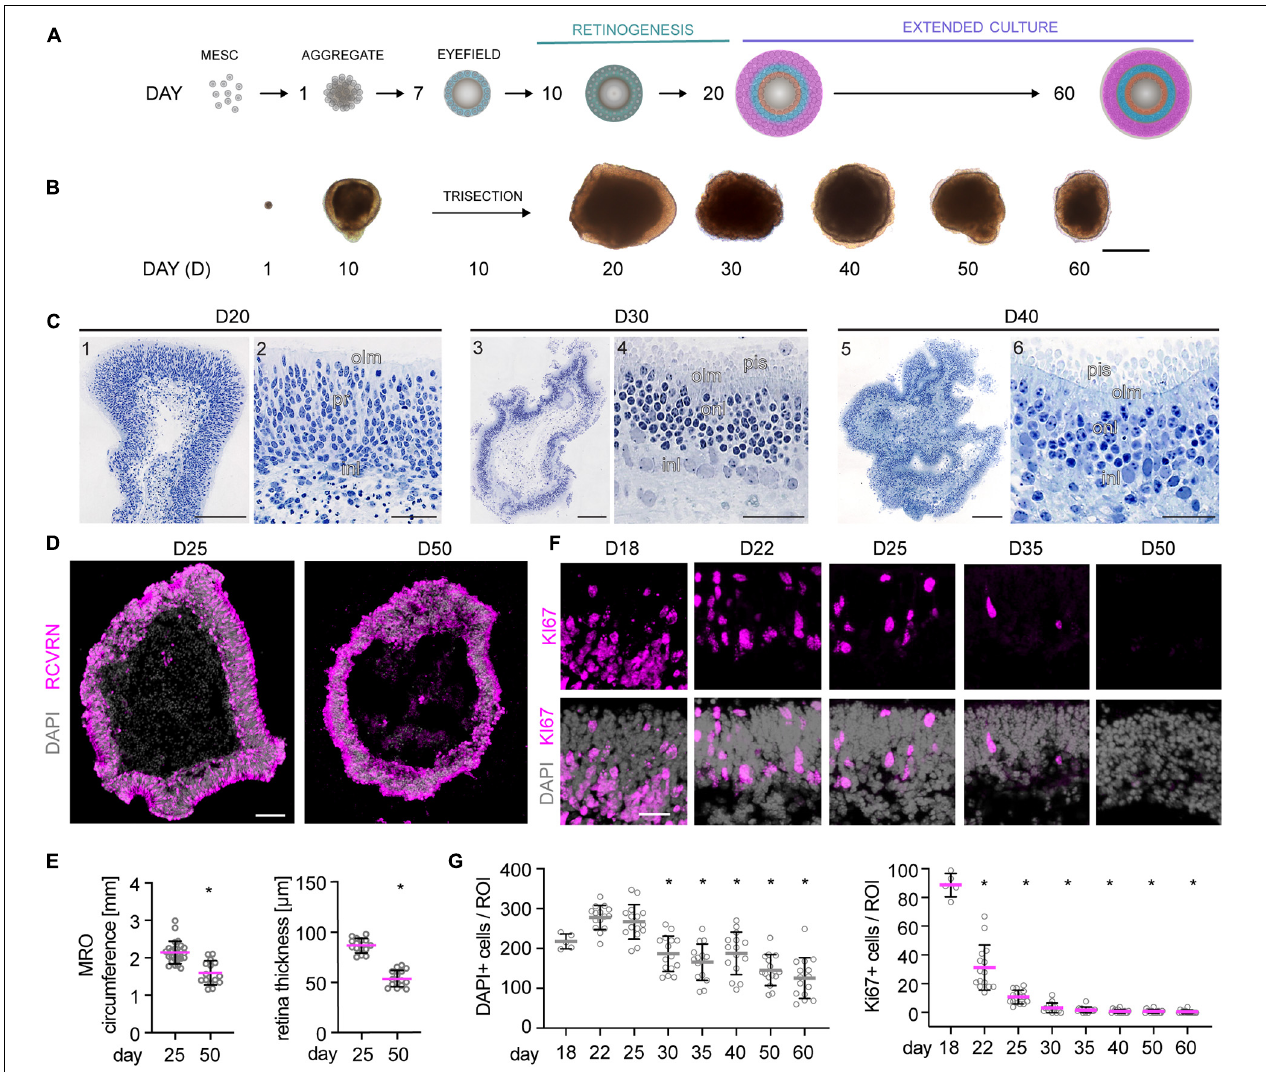
FIGURE 1 | Morpho-histological characterization of MROs within longer-term culture. (A) Schematic of the experimental approach. Mouse retina organoids (MROs) were differentiated as previously described (Völkner et al., 2016, 2019) and analyzed at different timepoints in extended culture after the end of retinogenesis (postmitotic). (B) Representative phase contrast images of MROs at different stages of differentiation, showing organoid growth during the first 20 days of culture. Upon extended culture, organoid size decreases and epithelia become less optically translucent. (C) Histology of methacrylate resin embedded MROs. (C1,2) D20, overview (1) and detail (2) showing a regular neuroepithelial layer with photoreceptors (pr) and interneurons (in). (C3,4) D30, overview (3) and detail (4) showing MRO with well-developed inner and outer nuclear layers (inl, onl), outer limiting membrane (olm) and photoreceptor inner segment (pis). (C5,6) D40, overview (5) and detail (6) showing photoreceptors with well-defined inner segments, a clear olm, but less clear border between outer and inner nuclear layers. (D) Overview image of organoid cryosections at D25 and D50 stained for RCVRN (photoreceptors) and DAPI. MROs decrease in size and the epithelia appear thinner at D50. (E) Quantification of MRO circumference and epithelial thickness on retinal cryosections. * p < 0.0001 (Student’s t -test). (F–G) Representative images and quantification of cell cycle marker KI67 and DAPI in MRO in extended culture. At D18, KI67 is still detected in many cells, but it becomes rapidly reduced thereafter, suggesting MRO become and remain postmitotic. The total cell number (DAPI) per region of interest (ROI) decreases from D30, suggesting cell loss. MRO were derived from (N) independent differentiations: D18 N = 1, all others N = 3. * p < 0.0001 (ANOVA). D, day. Scale bars: (B) 500 µ m; (C) 1, 3, 5: 200 µ m, and 2, 4, 6: 50 µ m; (D) 100 µ m; (F) 25 µ